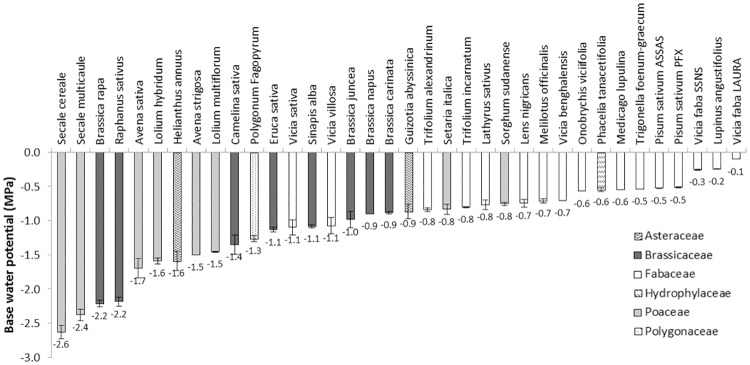
Base water potential for germination calculated for the 36 cover crops.Patterns and shades of gray correspond to botanical families. Data are the means of both 20th and 30th percentiles.